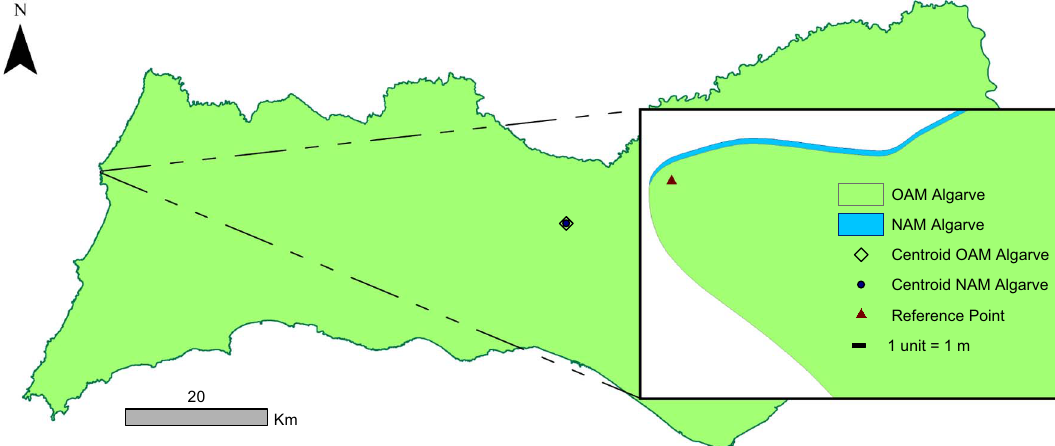
Figure 2. Distinctions between OAM Algarve (green) and NAM Algarve (blue) for TMzn.